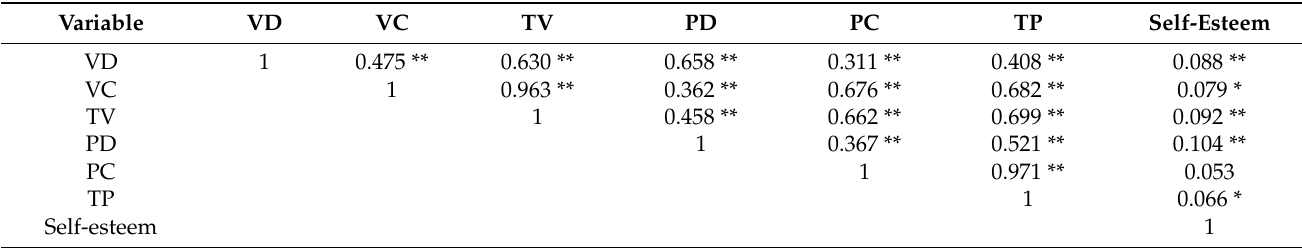
Table 1. Association between cyber dating abuse and